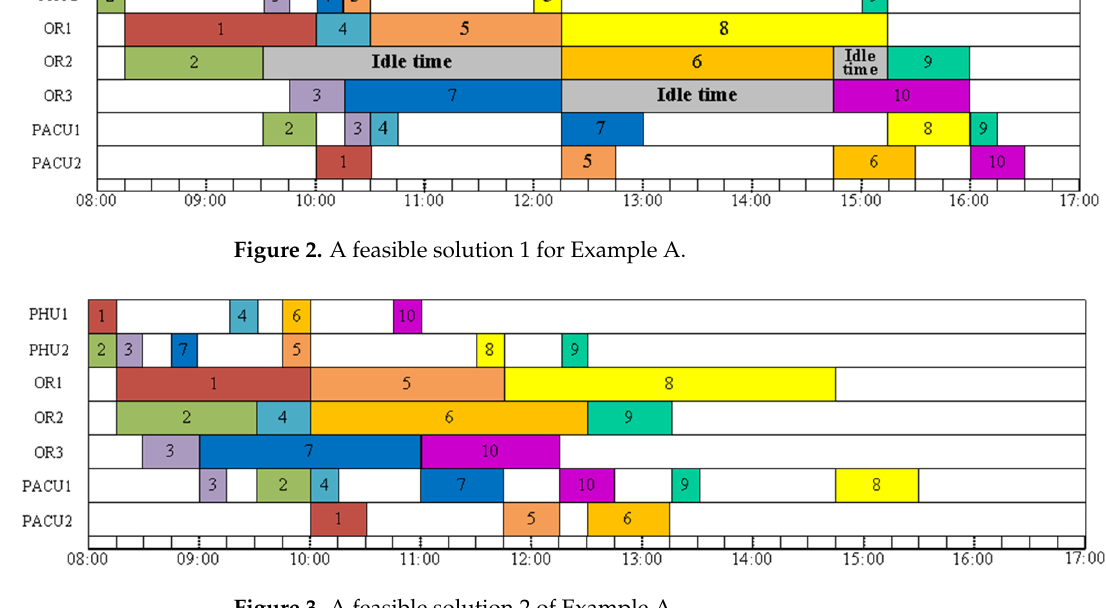
Figure 3. A feasible solution 2 of Example A.